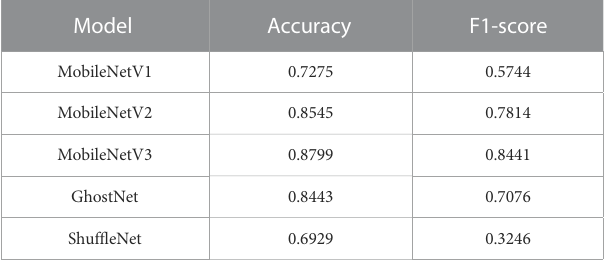
TABLE 2 Accuracy and F1-Score values concerning all models over the testing